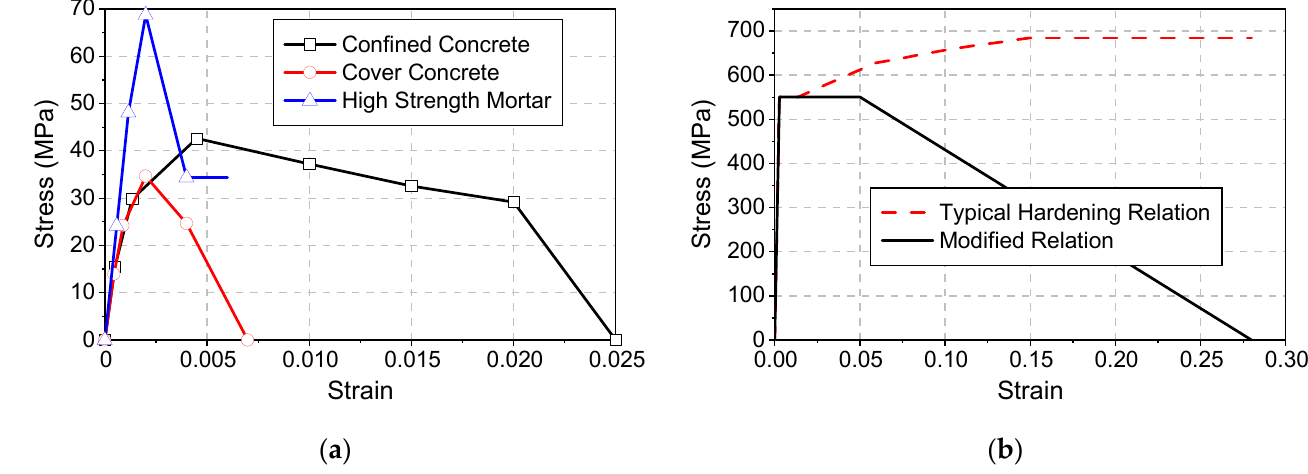
Figure 3. Stress–strain relation used in the FE model: ( a ) concrete and mortar; ( b ) rebar. The obtained axial yield and ultimate strength of longitudinal bars are 550.5 MPa There are two specimens tested in the experiment, and they are CIP reference #0 and